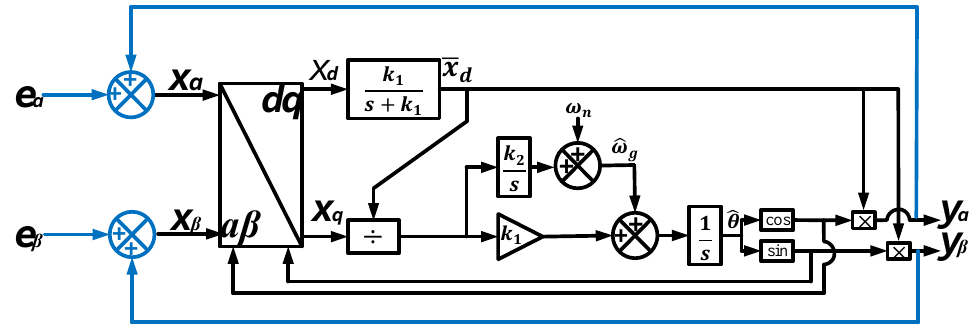
Figure 10. Proposed PLL-based controller [84].